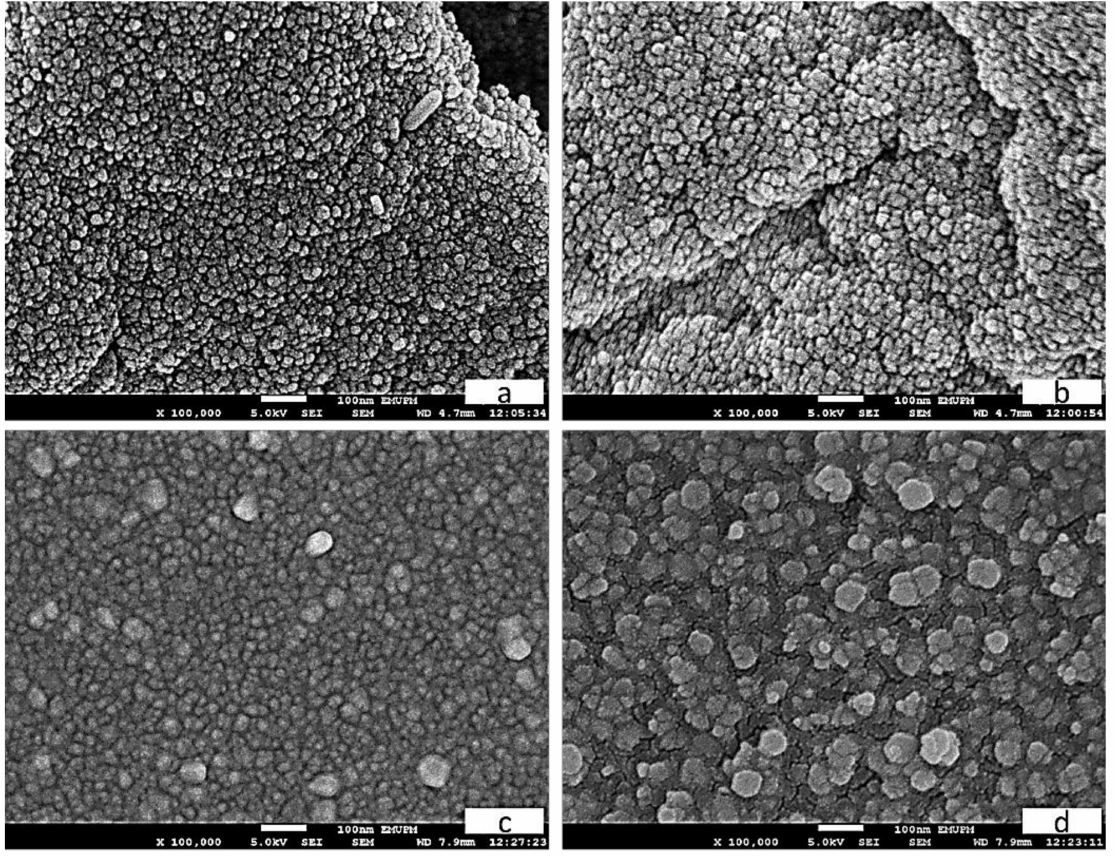
Figure 3. Nanoparticle SEM images at calcining temperatures of 500 ◦ C ( a ), 600 ◦ C ( b ), 700 ◦ C ( c ) and 800 ◦ C ( d ).